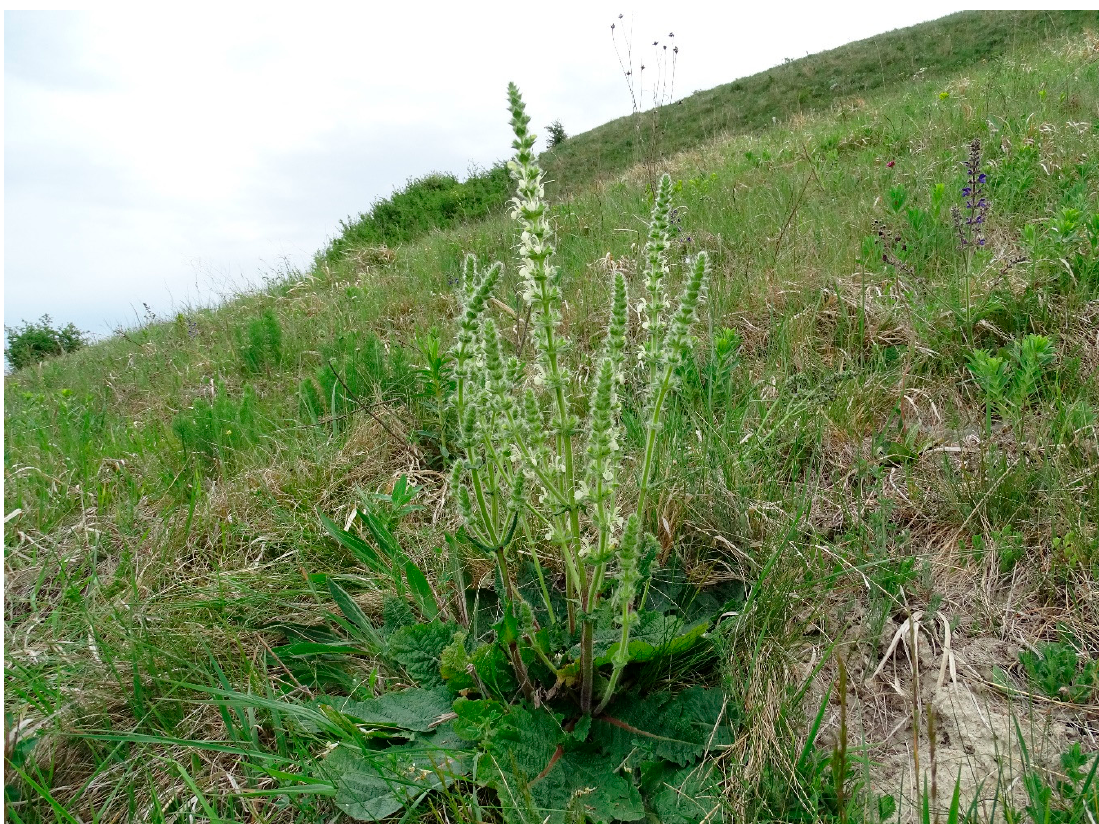
Figure 8. View of the studied steppe grassland on loess with Salvia austriaca in the foreground and S. pratensis in the upper right corner on 11 May 2020. (Photo: P. Csontos).